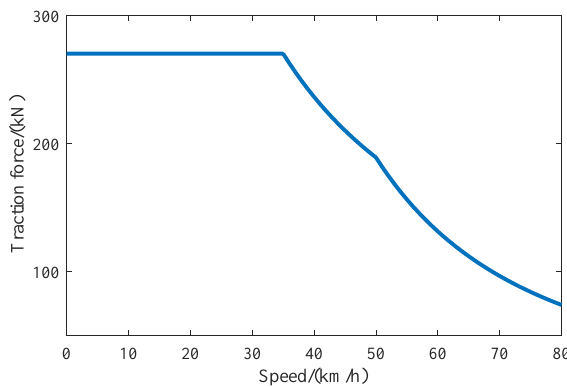
Figure 4. Traction characteristic curve of urban rail